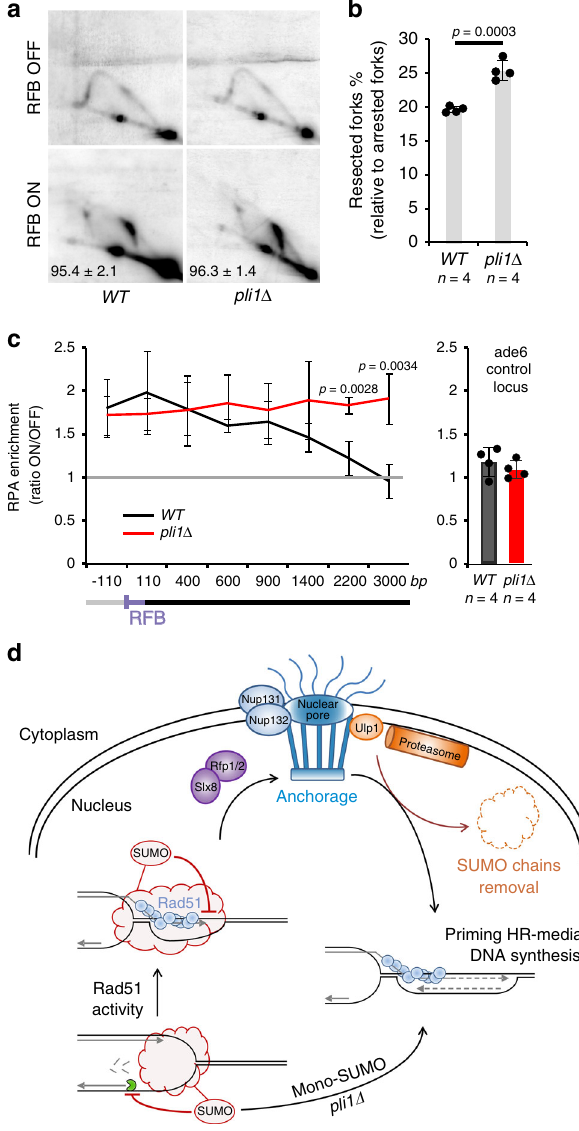
Fig. 7 Pli1 safeguards fork-integrity by limiting resection of nascent strands. a Representative RI analysis in indicated strains and conditions as described on Fig. 3. b Quanti fi cation of resected forks. Values are mean of four independent biological replicates ±SD. p value was calculated by two- sided t -test. c Binding of RPA (Ssb3-YFP) to the RFB in indicated strains. ChIP-qPCR results are presented as ON/OFF ratio for each mutant. Upstream and downstream distances from the RFB are presented in bp. Values are mean from four independent biological replicates ±SD. p value was calculated by two-sided t -test. Primers targeting ade6 gene were used as unrelated control locus. d SUMO-based regulation of relocation of remodeled forks to NPCs to promote RDR. See text for budding yeast Nup84 sustaining fork progression at stalled forks 41 , Nup132 is necessary to sustain DNA replication upon HU treat- ment. The deletion of Pli1 did not rescue the defect in the recovery from HU-stalled forks in nup132 Δ cells (Supplementary Fig. 5), indicating that Nup132 sustains DNA replication upon stress by distinct mechanisms according to the nature of stalled versus dysfunctional forks.